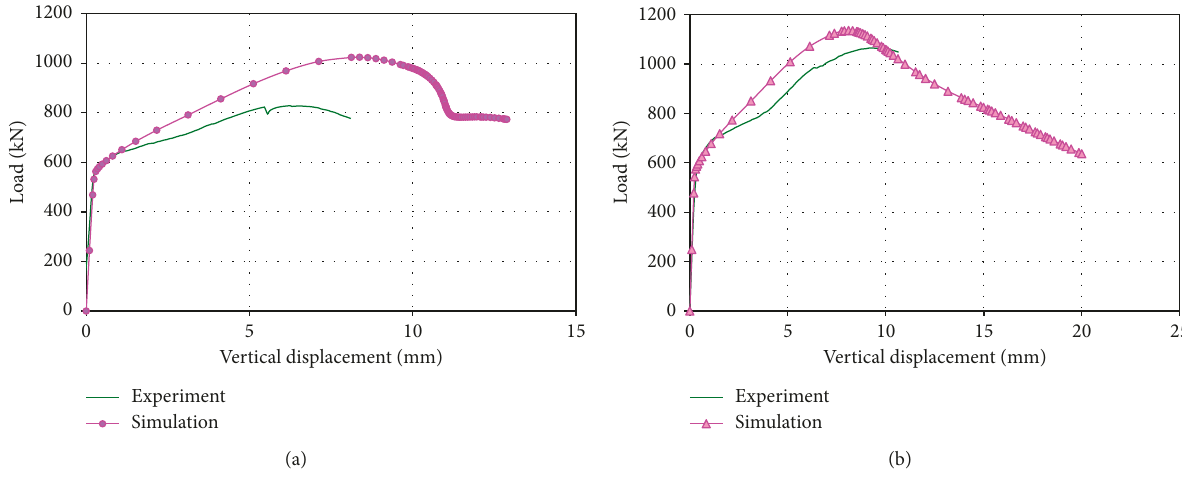
Figure 18: Experiment and simulation: (a) 3 CFRP layers; (b) 4 CFRP